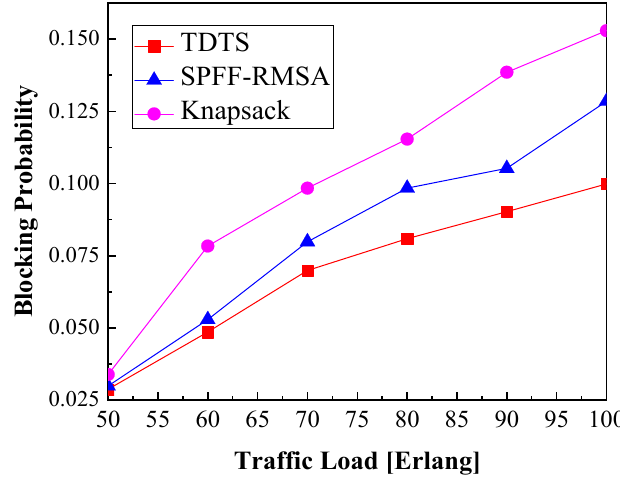
Figure 11. Blocking probability of TDTS, SPFF-RMSA, and Knapsack.